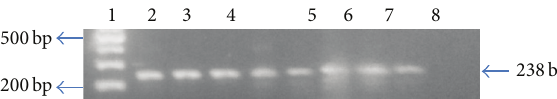
Figure 2: A representative gel picture of ethidium bromide-stained 2% agarose gel showing 17 𝛽 HSD-1 methylation status of two cases.